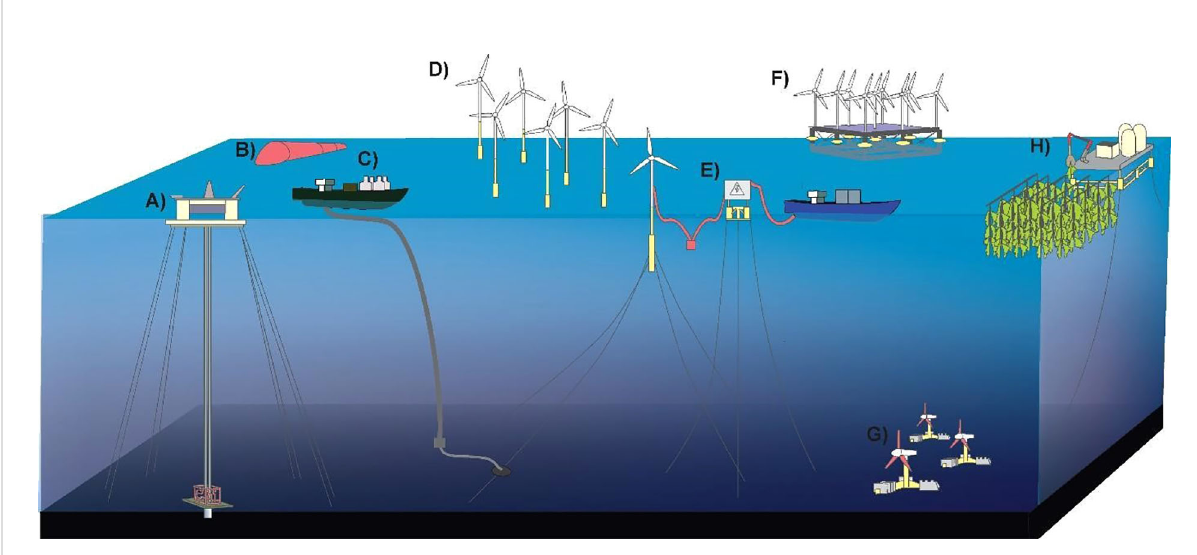
FIGURE 2 Schematic representation of different types of energy industries in current or potential development in the deep ocean. (A) Oil and gas, (B) wave energy, (C) ocean thermal energy conversion (OTEC), (D) wind energy, (E) green hydrogen, (F) device combining wind, sun and wave energy, (G) ocean current energy, (H)